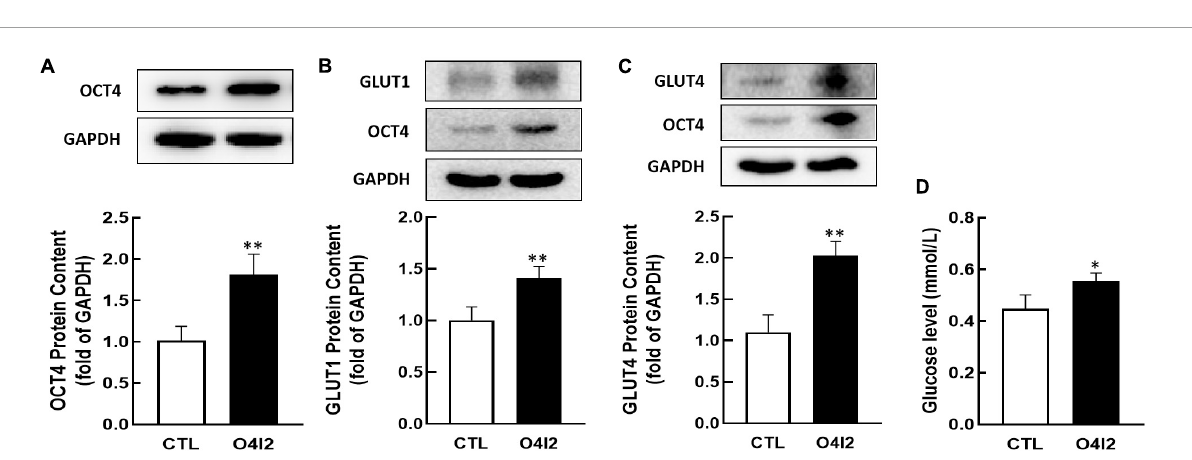
FIGURE6 Effect of O4I2 on GLUT1/4 expression and cellular glucose uptake. KGN cell were co-cultured with O4I2 (12.5 µ M) for 24 h. The protein contents of OCT4 (A) , GLUT1 (B) , and GLUT4 (C) content were assessed by Western blot analysis. And 2-DG measurement was used for detecting the cellular glucose uptake (D) . Data are presented as mean ± SEM of three independent experiments. ∗ P < 0.05, ∗∗ P < 0.01 compared with